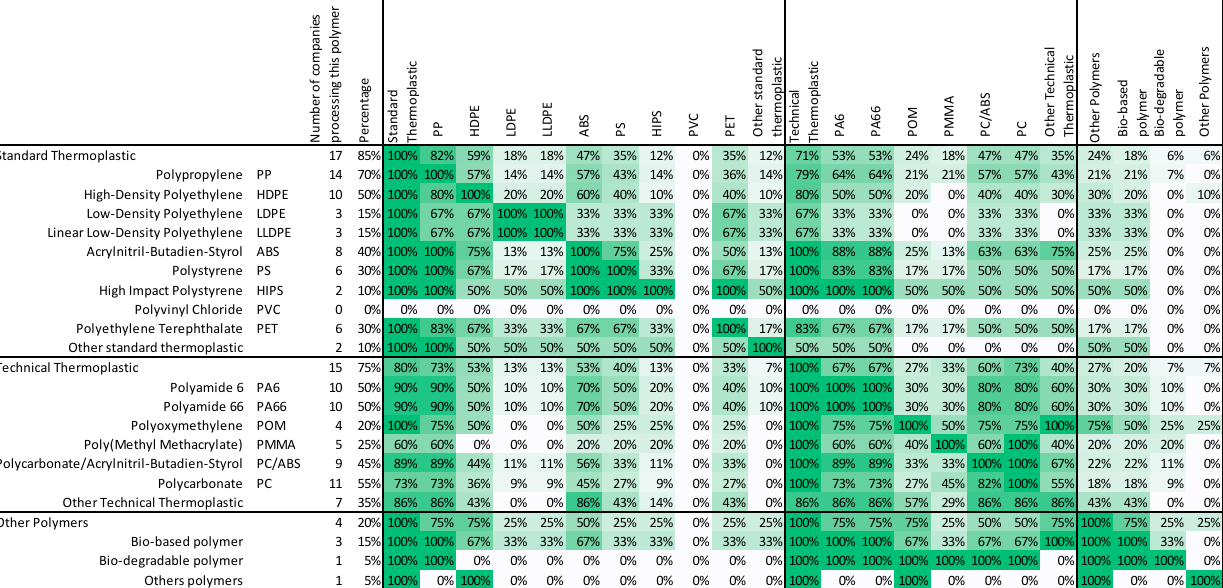
Figure 3. Processed polymers and combinations of polymers being processed together.